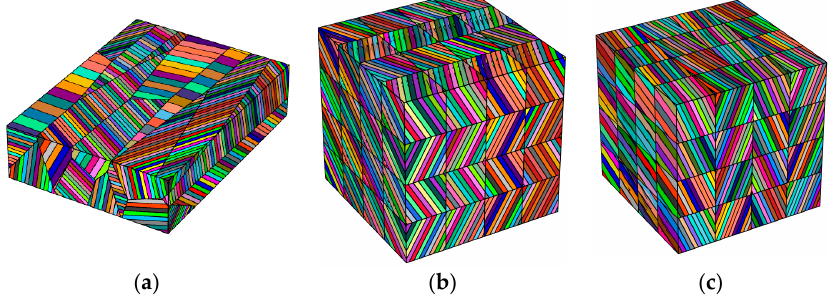
Figure 3. Exemplary grain microstructure models generated using Voronoi tessellation. The grains contain idealized, fine lamellae typical for acicular matensitic phases: ( a ) Polycrystal microstructure with elongated grains maintaining a length/width ratio > 2.5, with lamellar structure; ( b ) Idealized herringbone structure obtained for defined scanning strategy; ( c ) Oblique pattern assumed for arbitrary scanning strategy.